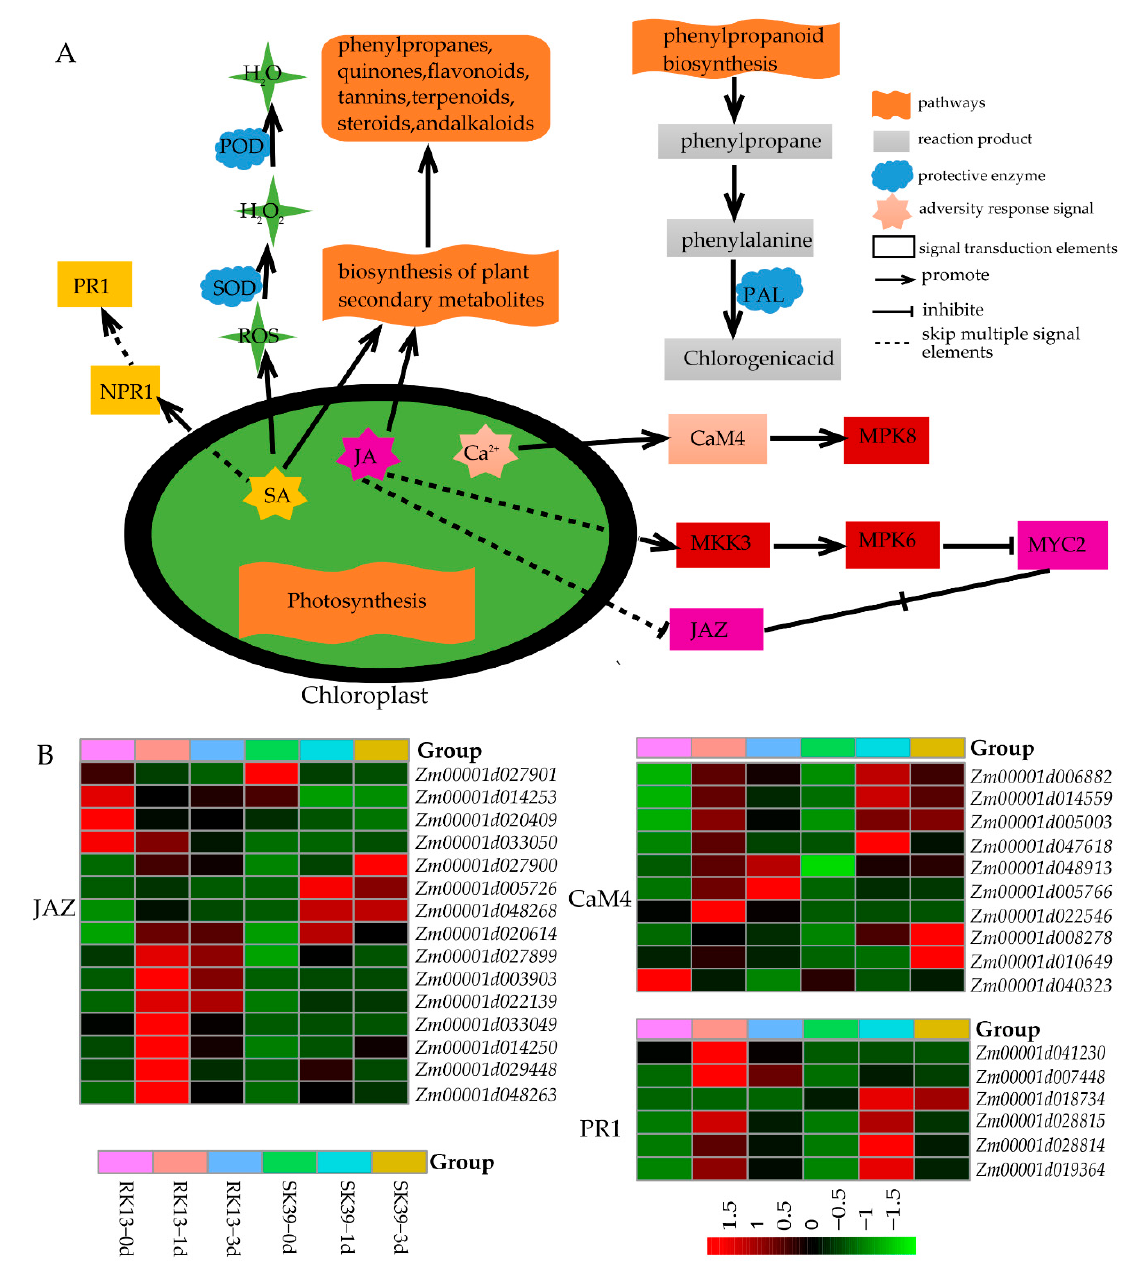
Figure 5. The important pathways of sweet corn response to SCLB and the gene expression patterns of related elements. ( A ) The important pathways of sweet corn response to SCLB. ( B ) The gene expression patterns of related elements. Red means high expression, green means low expression.